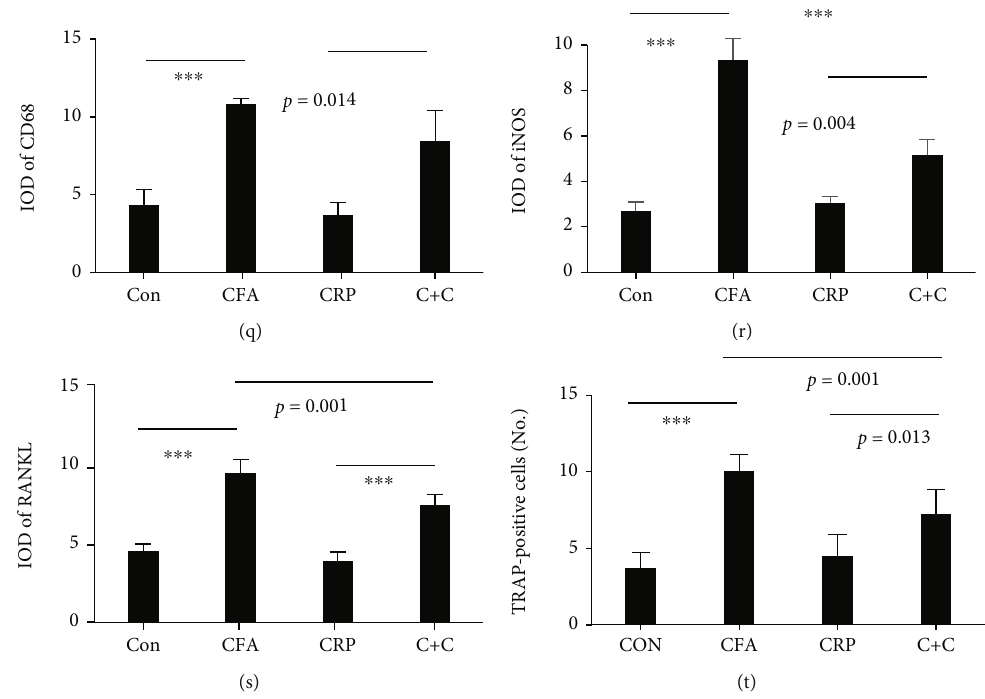
Figure 7: Macrophage and osteoclast activities and photomicrographs of immunopositive cells in the synovium and cartilage. (a) – (d) The IHC results of CD68 expression in the synovial membrane from Con, CFA, CRP, and C + C groups, respectively. (e) – (h) The IHC results of iNOS from Con, CFA, CRP, and C + C groups, respectively. (i) – (l) The IHC results of RANKL expression in the TMJ cartilage from Con, CFA, CRP, and C + C groups, respectively. (m) – (p) TRAP staining of subchondral bone from Con, CFA, CRP, and C + C groups, respectively. (q) – (s) Semiquantitative analysis of (a) – (l). (t) Statistical results of TRAP-positive cells (clusters of more than 3 nuclei were counted as one osteoclast) in the di ff erent groups. ( N = 6 ; mean + SD ; ∗∗∗ p < 0 : 001